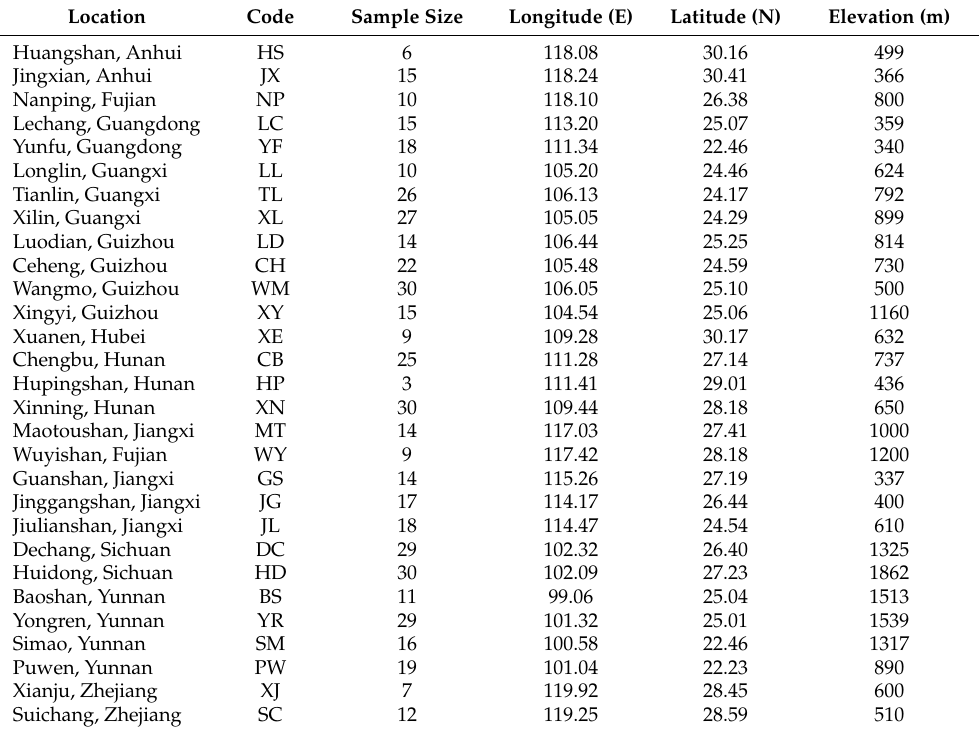
Table 1. Locations and sample sizes of 29 populations of T. ciliata